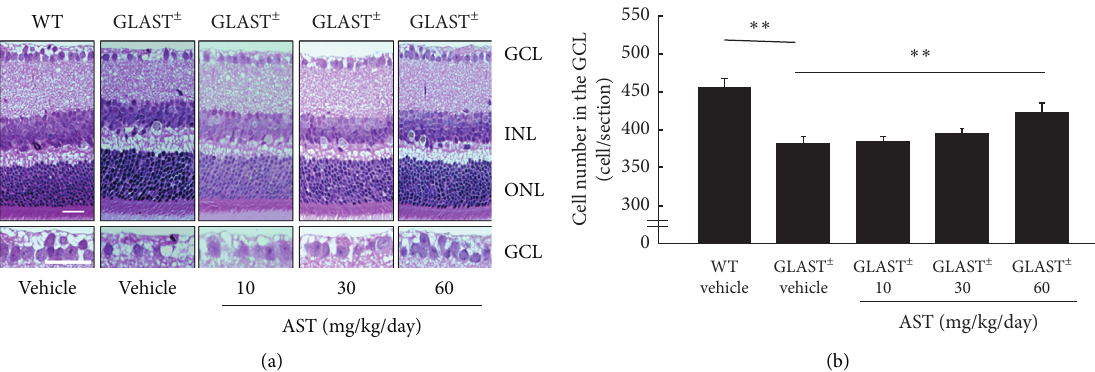
Figure 1: Dose-dependent inhibition of RGC loss by AST administration. (a) H & E staining of retinal sections. GCL: ganglion cell layer; INL: inner nuclear layer; ONL: outer nuclear layer. Scale bars: 25 μ m. (b) Quantification of cell number per section in the GCL. ∗∗ P < 0 . 01.